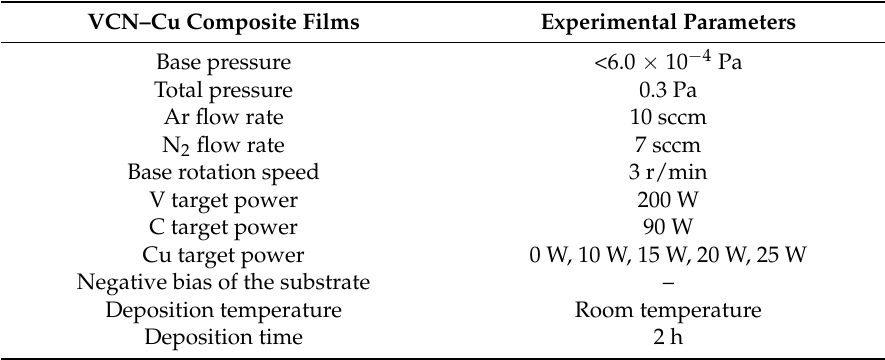
Table 1. The preparation parameters of VCN–Cu composite